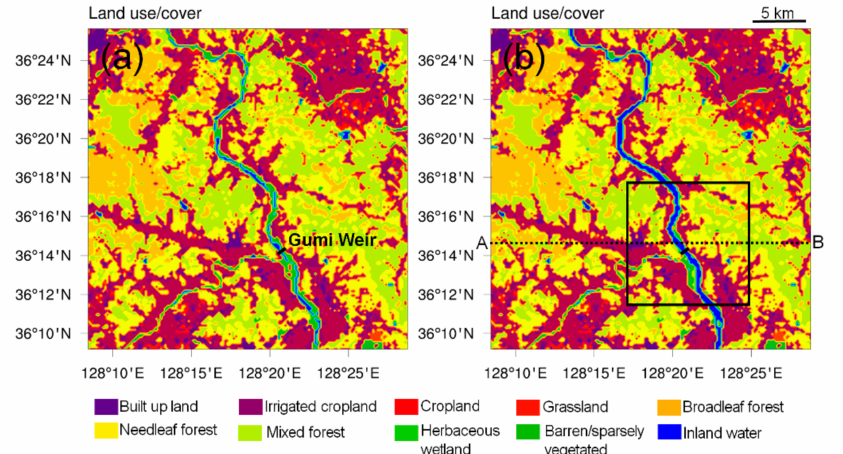
Figure 2. LULC map before ( a ) and after ( b ) the construction of the Gumi Weir. LULC data have a 30m horizontal resolution from the Korean Ministry of Environment. An unfilled square is an analysis area, and line A–B is used for range analysis of weather variables